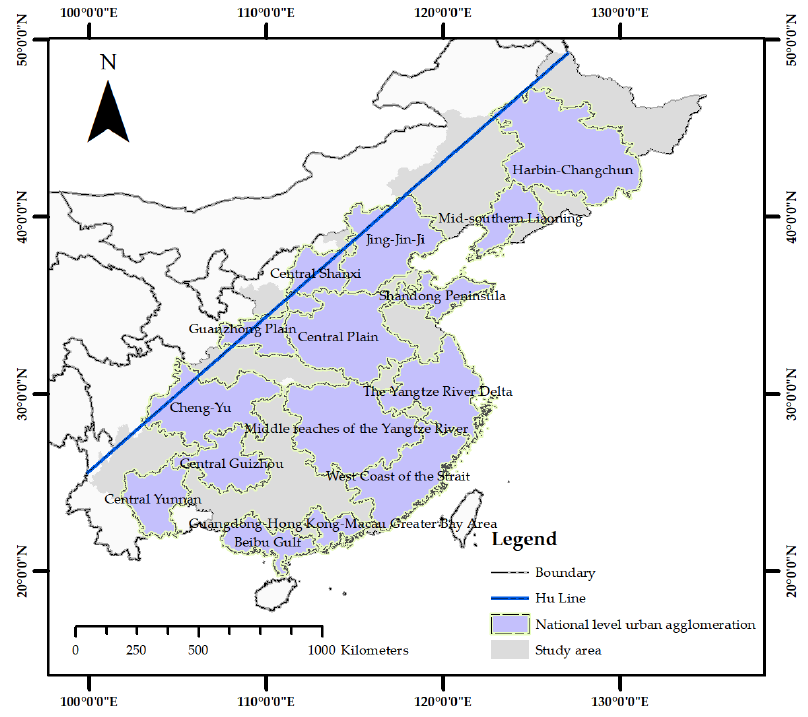
Figure 1. The study